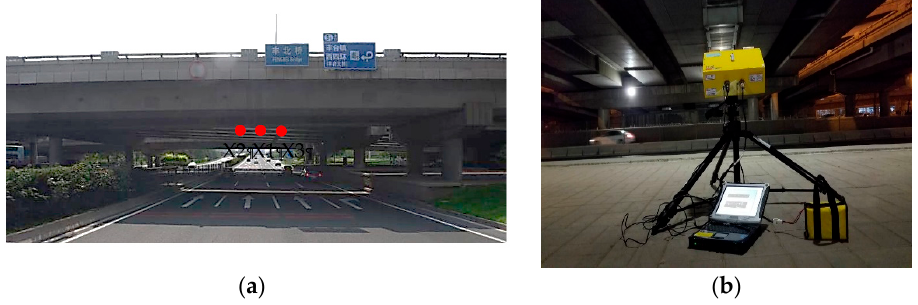
Figure 6. The Fengbei Bridge and the IBIS-S instrument layout. ( a ) The Fengbei Bridge and ( b ) the dynamic deflection measurement of the Fengbei bridge using IBIS-S.